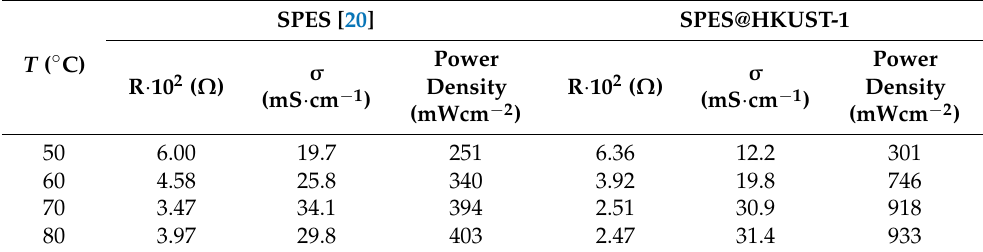
Table 2. In situ ionic conductivity and maximum power density values for the SPES and SPES@HKUST-1 membranes as a function of temperature.